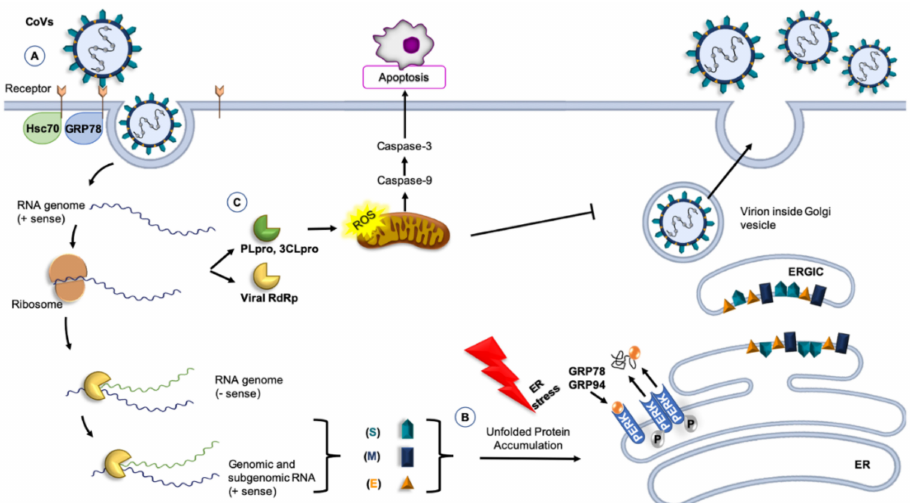
Figure 1. CoVs and molecular chaperones. ( A ) GRP78 or 74-kDa heat shock cognate protein 70 (Hsc70) can be part of the receptor complex recognized by the CoVs and can modulate virus entry [82–84]. ( B ) Molecular chaperones, such as GRP78 and GRP94, participate in the folding of CoV proteins, counteracting the e ff ect of the stress of the host cell caused by viral infection. Accumulation of unfolded proteins induces the transcription of GRP78 and GRP94. In the endoplasmic reticulum (ER) lumen, the release of GRP78 and GRP94 from PERK are protective, inducing the unfolded protein response and controlling proteins folding. Under these conditions, ER homeostasis is restored [85]. ( C )Non-structuralproteins, suchas3C-likeserineprotease(3CLpro), induceapoptosisthoughtcaspase’s pathways, causing a significant increase in reactive oxygen species (ROS) [86]. Other abbreviations: RBD, receptor-binding domain (of the S protein); PLpro, papain-like cysteine protease; RdRp, RNA-dependent RNA polymerase; PERK, PKR-like endoplasmic reticulum kinase; ERGIC, Endoplasmic reticulum-Golgi intermediate